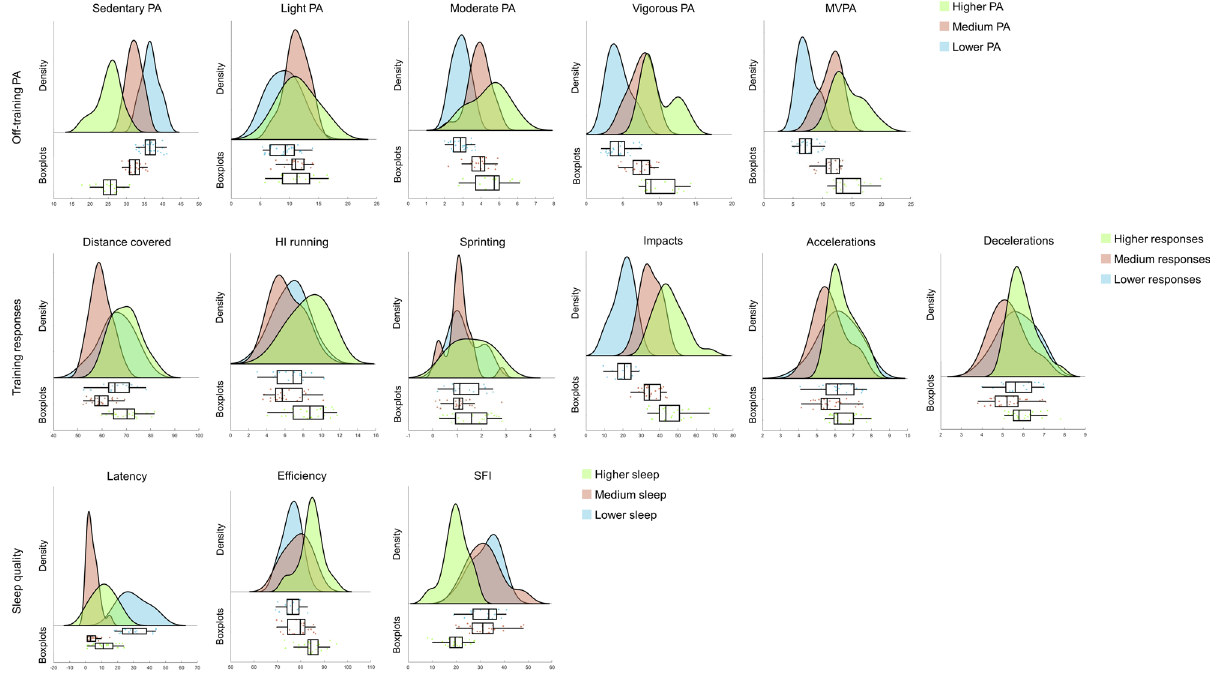
Figure 1. Raincloud plots showing the distribution of the variables according to the clusters obtained. The density plots indicate the data distribution and the boxplots indicate the data distribution, the median and the 1st quartile (25th percentile) and the 3rd quartile (75th percentile), for each group. MVPA moderate-to-vigorous physical activity, PA physical activity, SFI sleep fragmentation (n = 16 data points), cluster 2 was labeled as Medium responses (n = 26 data points), and cluster 3 was labeled as Higher responses (n = 24 data points). Cluster Lower responses demonstrated greater total distance covered (66.14 ± 6.84); however, revealed the lowest proportion of impacts (20.42 ± 5.49). Cluster Medium responses presented a slightly lower training workload than the previous cluster, but a notably higher number of impacts (35.11 ± 5.24). Cluster Higher responses displayed the highest mean for all training-related variables. Sleep onset latency revealed a higher magnitude to differentiating the clusters; with sleep efficiency being less influential. Cluster 1 was labeled as Lower sleep (n = 18 data points), cluster 2 was labeled as Medium sleep (n = 21 data points), and cluster 3 was labeled as Higher sleep (n = 27 data points). Cluster Lower sleep disclosed the higher latency (30.17 ± 8.69) and sleep fragmentation index (SFI) (32.18 ± 6.02), but the lowest efficiency (76.12 ± 3.71). Cluster Medium revealed slightly lower SFI (32.05 ± 7.44) and higher efficiency (78.39 ± 5.28) compared to the aforementioned cluster, and the lowest latency. Finally, cluster Higher sleep showed the highest efficiency (84.41 ± 5.09) and the least SFI (19.98 ± 4.86) among sleep clusters. The process of summarizing the interactions between rows (off-training PA) and columns (training responses) was conducted for all sleep groups, whereby the outputs are presented as a solution of two dimensions. For the Lower sleep group results showed the first dimension was characterized by Lower off-training PA (as the relative inertia and cosine 2 values exhibit) (see Table 2 and Fig. 2a) and a second dimension was most related to the Higher off-training PA profile. In the same sleep group, a similar trend was observed for Lower training responses (dimension 1, 69.06% of inertia) in contrast with the Higher training responses (dimension 2, 30.94% of inertia). The quadrants in Fig. 2a, suggest that Higher training responses are near the Medium off-training PA, that Medium responses are near the Higher off-training PA and there is independence from Lower off-training PA and Lower training response (these categories are located separately in different quadrants). For the Medium sleep group results showed the first dimension was characterized by a Lower off-training PA profile (as the relative inertia and cosine 2 values exhibit) (see Table 2 and Fig. 2b) and a second dimen- sion was most related to the Higher and Medium PA profiles. Regarding the training response, a similar trend was observed for Medium and Lower responses (dimension 1, 72.97% of inertia) in contrast with the Higher responses (dimension 2, 27.03% of inertia). Analyzing the quadrants in Fig. 2b, correspondence can be observed between Higher off-training PA and Higher training responses, Medium off-training PA and Lower training responses, and possibly independence from the Lower off-training PA profile and Medium training responses. For the Higher sleep group results showed the first dimension was characterized by the Lower and Medium off-training PA profiles (see Table 2 and Fig. 2c) and a second dimension was most related to the Higher off- training PA. For the training responses, dimension 1 (94.43% of inertia) was described by Medium and Higher responses, having dimension 2 (5.72% of inertia) a relation with the Lower responses. The quadrants from Fig. 2c are less clear. It is possible to perceive a slight correspondence between Medium off-training PA and Medium training responses and independence from the additional off-training profiles and training responses.